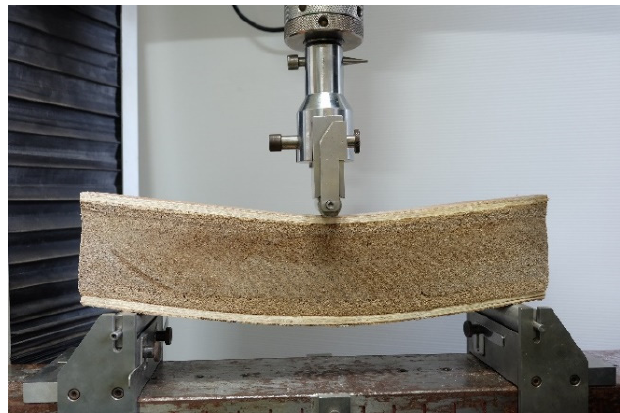
Figure 5. Three-point bending test of SIP prototype.